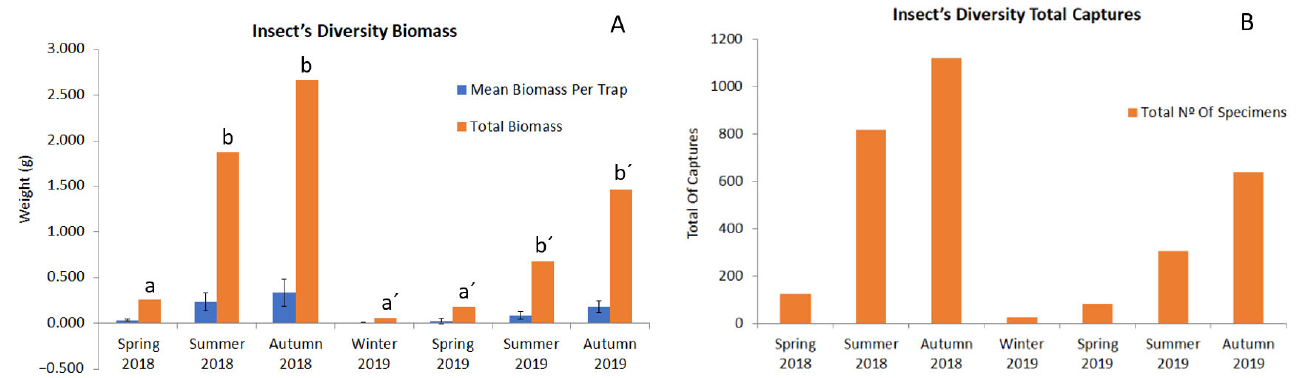
Figure 8. Total and mean biomass ( A ) and total captures ( B ) of insect diversity collected by vinegar bottle traps in QV. Different letters indicate a significant difference among them ( p ≤ 0.05). 2018 is represented with the letters a and b, and 2019 with a’ and b’. The C. capitata plague was also monitored and the results are shown as the number of captures through the seasons in Table 9, which also shows the number of captured males and females and the total biomass of the captures. Data for the winter season of 2018 were not obtained.